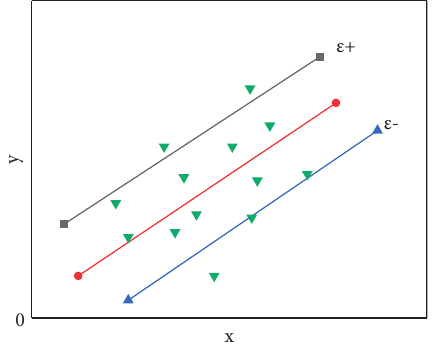
Figure 3: ε -insensitive